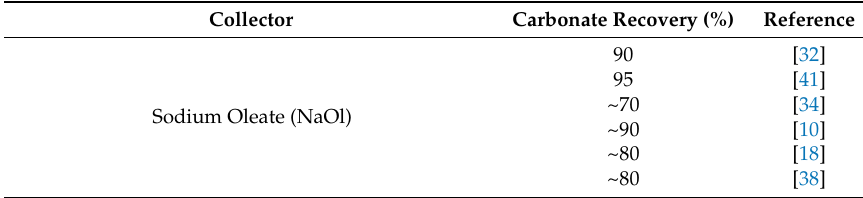
Table 3. Various anionic and cationic collectors for direct flotation of Mg